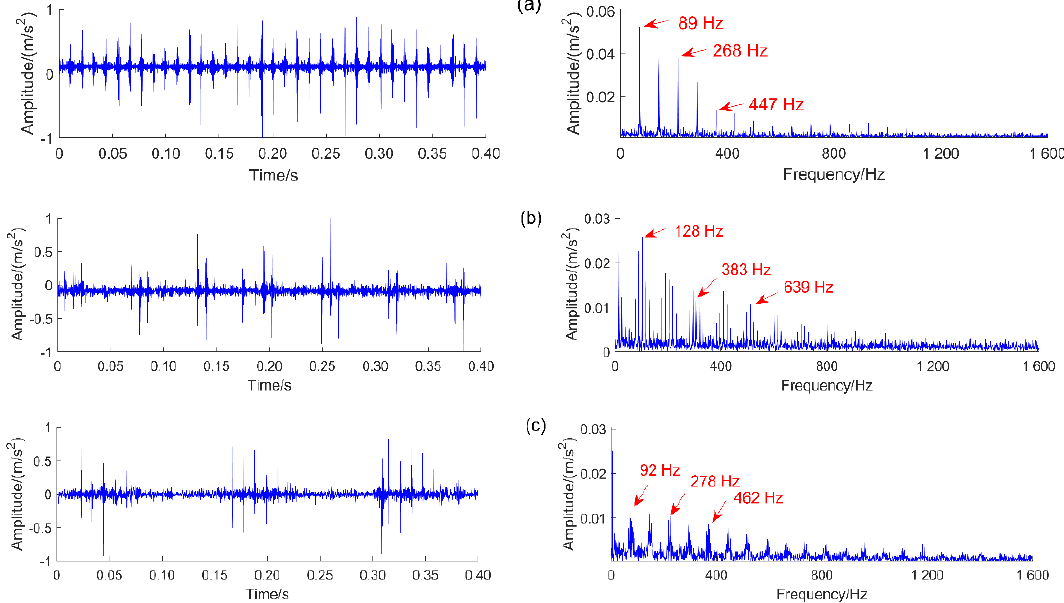
Figure 4. Simulation signals of different fault types and corresponding envelope spectra: ( a ) outer ring fault; ( b ) inner ring fault; ( c ) rolling element fault.